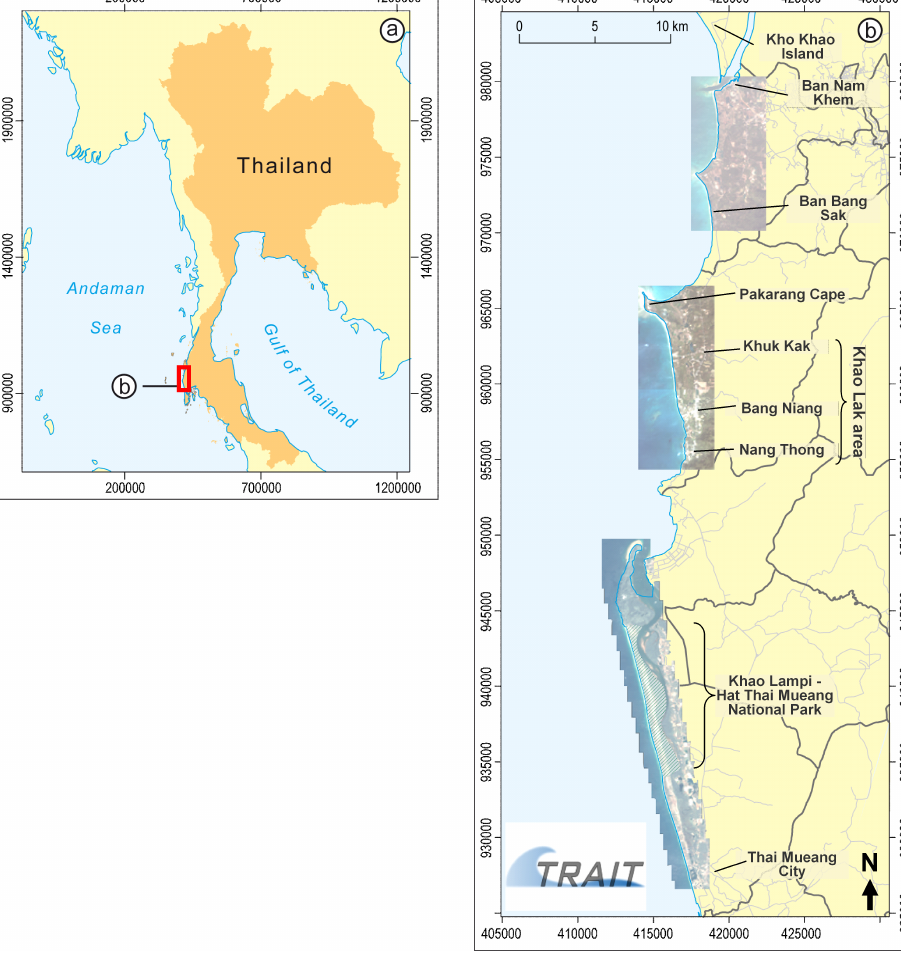
Fig. 1. Study area. Satellite images are based on IKONOS multispectral data from 13 January 2003. The administrative units are at the community level